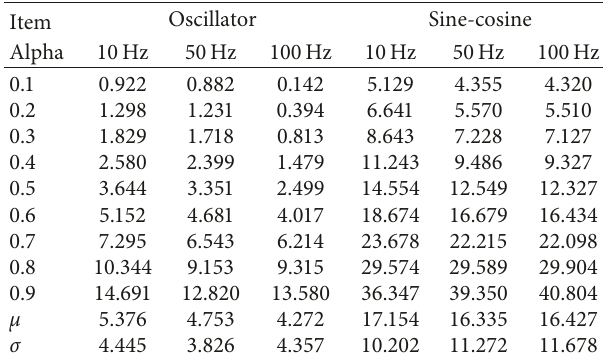
Figure 3: Root mean-squared error (RMSE) between fractional derivatives calculated with both GL and RL methods, with different sample rates. (a) RMSE of oscillator signal. (b) RMSE of the sine-cosine signal. Table 1: Root mean-squared error for different fractional